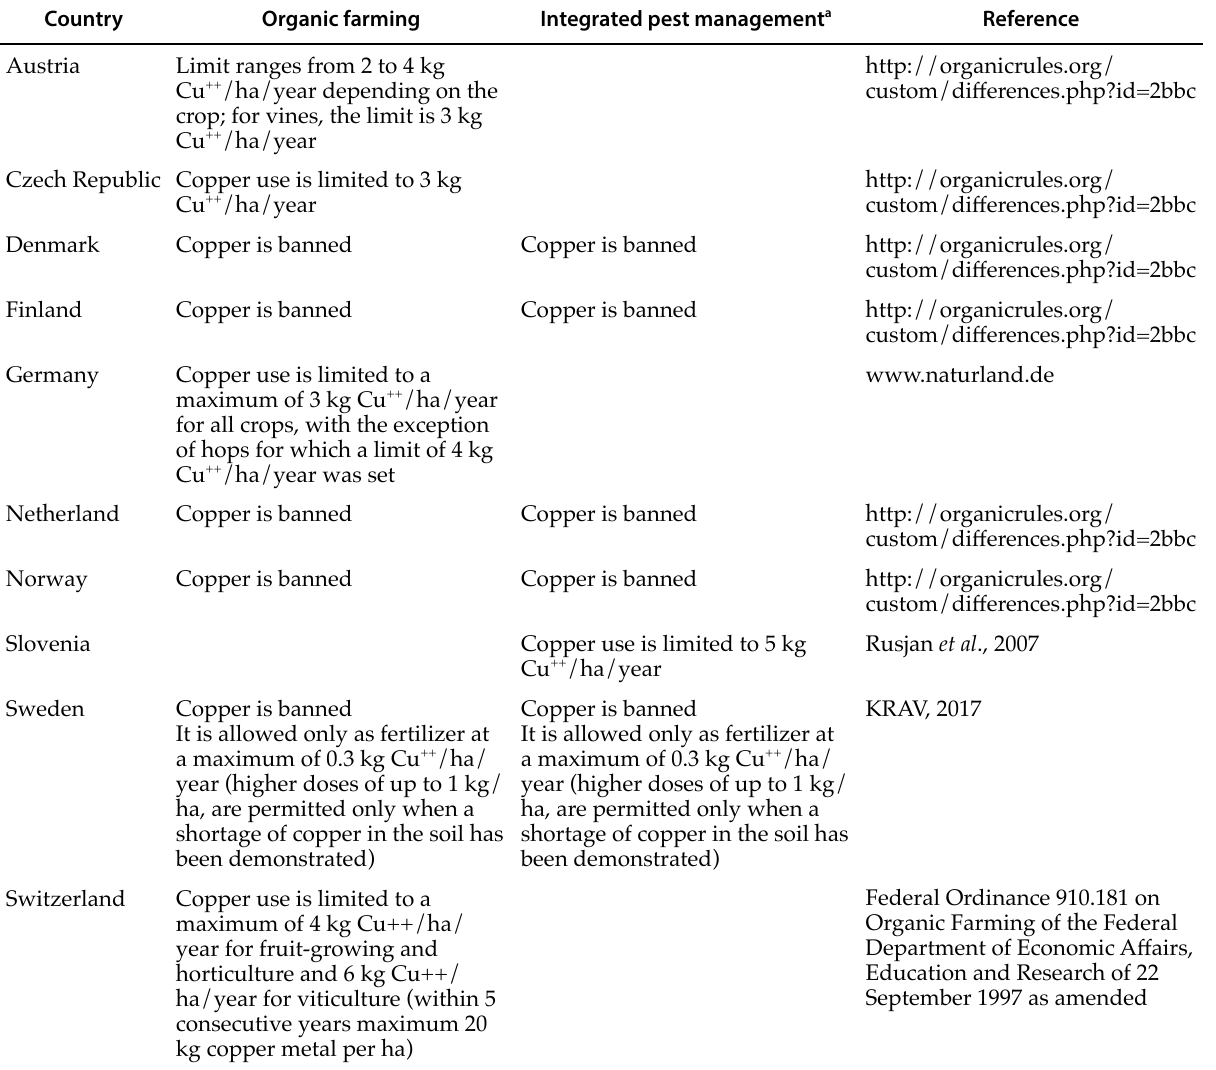
Table 2. Restrictions and bans on copper use in some European countries. Country Organic farming Integrated pest management